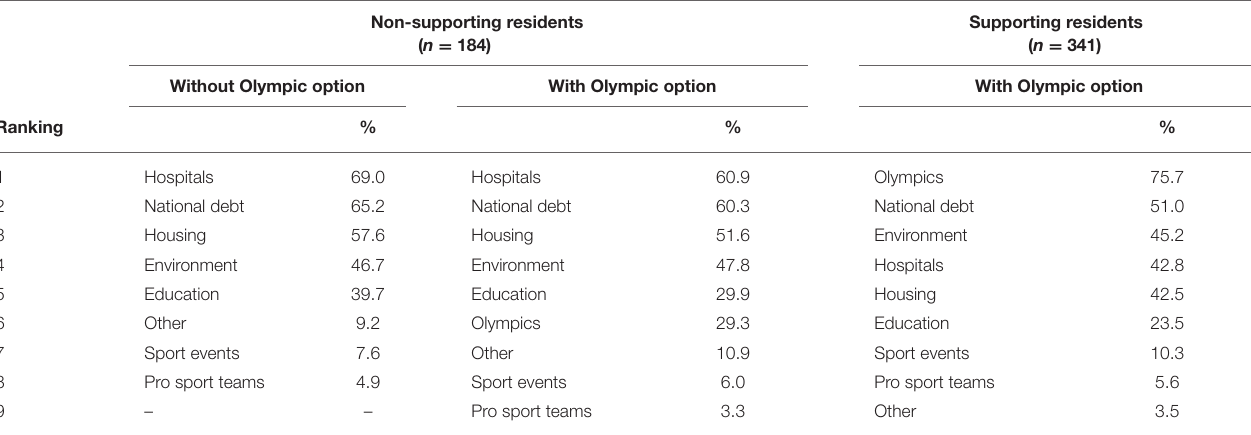
TABLE 3 | Macro-Level social value perspective: opportunity cost approach.